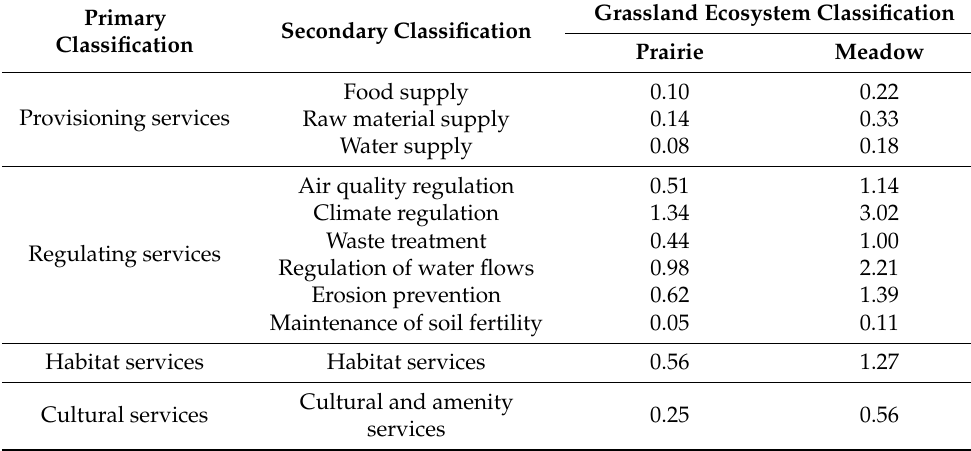
Table 1. The equivalent coefficients table for ecosystem service value (ESV) per unit area for the grassland ecosystem and four ecosystem